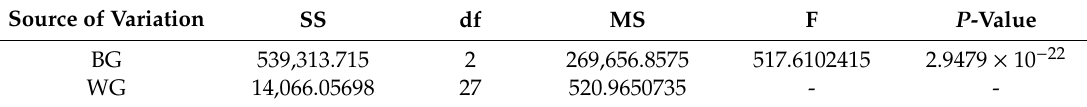
Number of observations = 30.